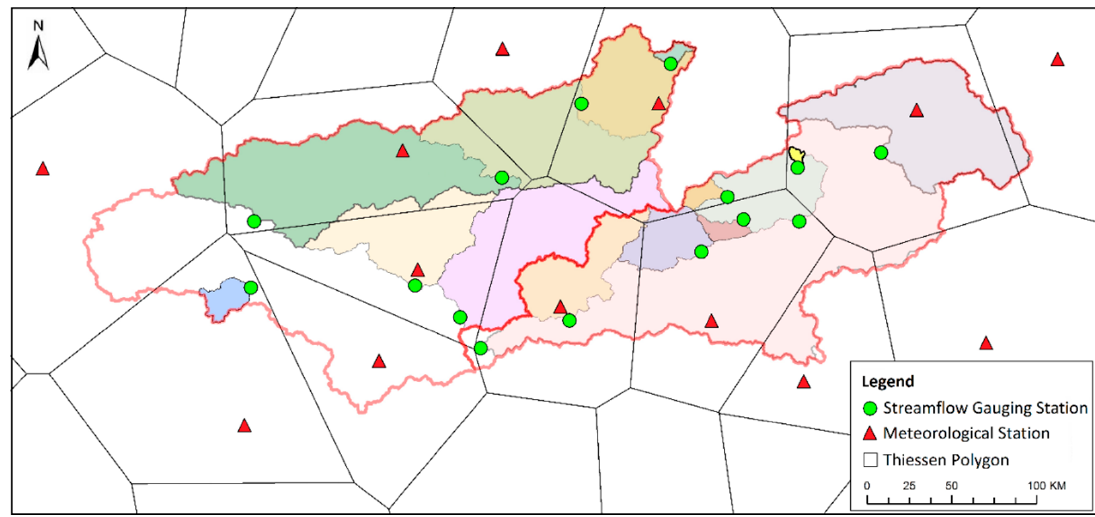
Figure 4. Meteorological stations and Thiessen polygons of the study area. Table 3. Statistics of physical characteristics used in the Middle Euphrates Basin.